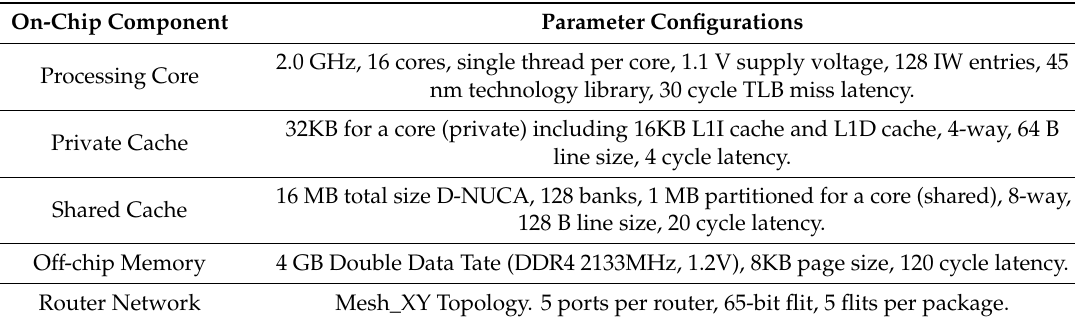
Table 3. Parameter configurations on the simulation